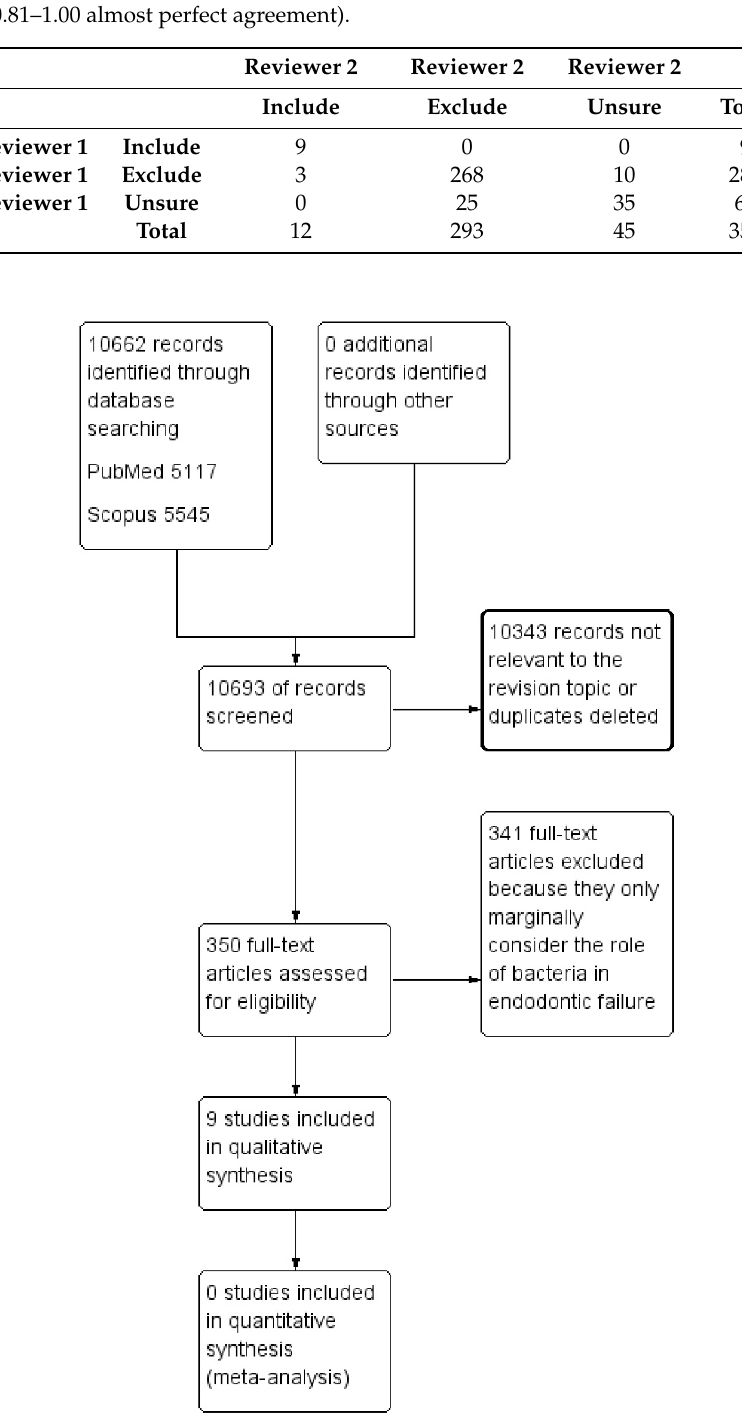
Table 1. K-agreement calculation, Po = 0.8914, Pe = 0.695, K-agreement = 0.644 ( < 0 no agreement, 0.0–